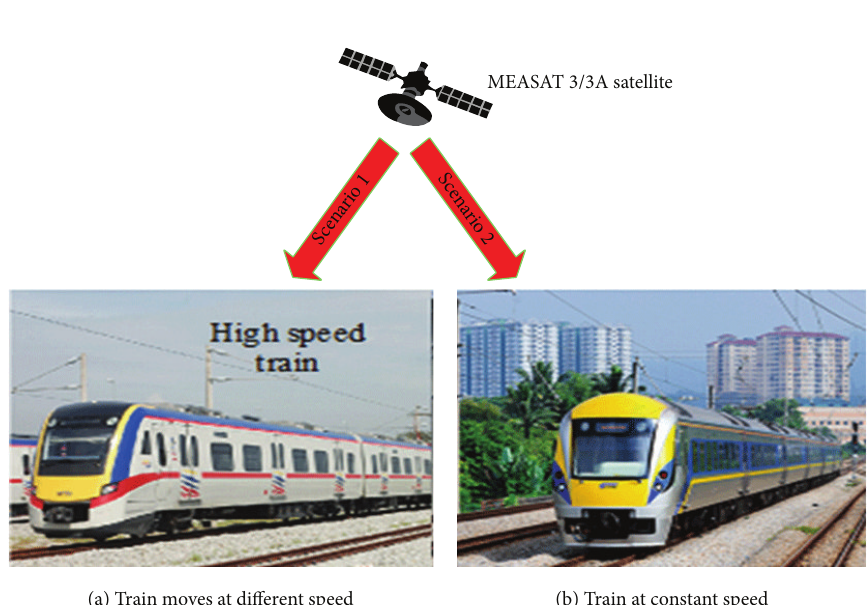
Figure 1: The scenarios for high speed train environment.